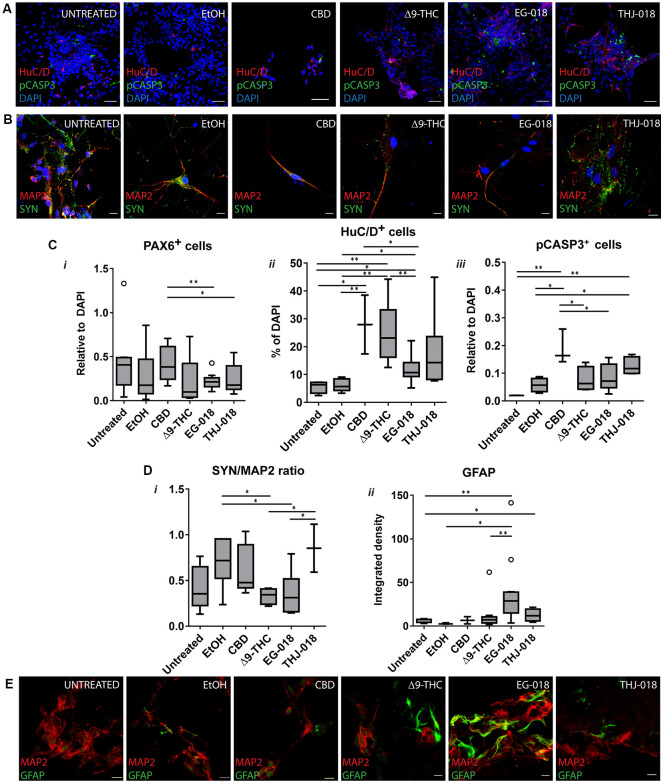
Effect of cannabinoid exposure on day 30 and 56 of neural differentiation. (A) Immunofluorescence for newborn neuronal marker HuC/D and apoptosis marker pCASPASE3 (pCASP3) at day 30 showing an increase in HuC/D staining and apoptotic cells in s cannabinoid-treated cultures. Scale bars: 15 μm. (B) Immunofluorescence for neuronal (MAP2) and synaptic protein synaptophysin (SYN) in cultures continuously exposed to cannabinoids from day 19 to day 56. Scale bars: 15 μm. (C) Quantification of PAX6+
(i), HuC/D+
(ii) and pCASP3+
(iii) cells at day 30, relative to DAPI. Results for three independent experiments. (D) Quantification of the ratio of fluorescence intensity of SYN and MAP2 in day 56 cultures (i), and of integrated fluorescence density for GFAP (ii). Data from three independent experiments, 3–10 images per condition. Data in (C) and (D) analyzed by unpaired t-test; *p < 0.05, **p < 0.01; error bars represent SEM. Tukey’s range test was applied to determine outlier data points (open circles). (E) Immunofluorescence for glial (GFAP) marker and MAP2 in cultures continuously exposed to cannabinoids from day 19 to day 56. Scale bars: 15 μm.